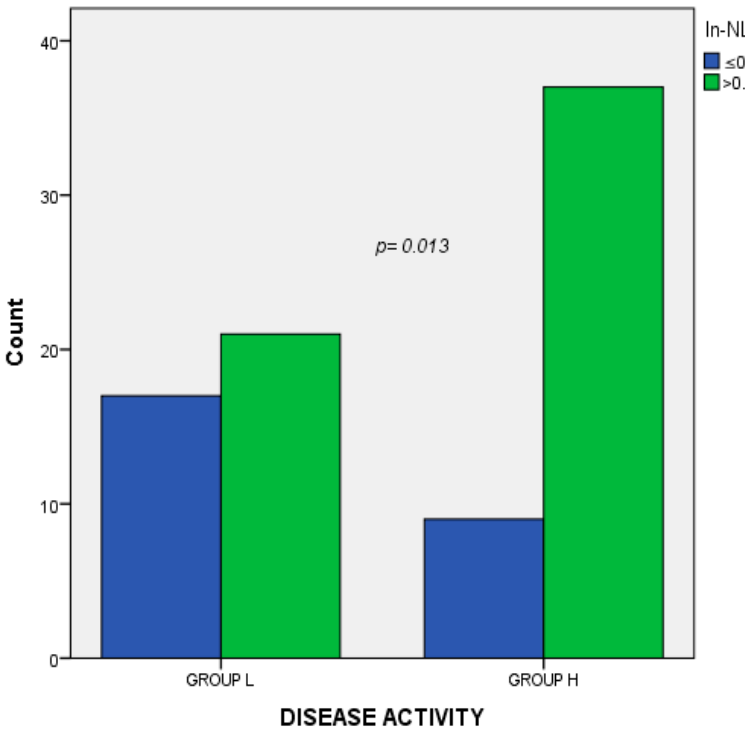
Figure 3. Association analysis between disease activity and the ln-NLR. Group L, Low disease activity; Group H, High disease activity; ln.NLR log transformation of the neutrophil to lymphocyte ratio. Table 2. Association analysis between the ln-NLR and demographical / clinical parameters.